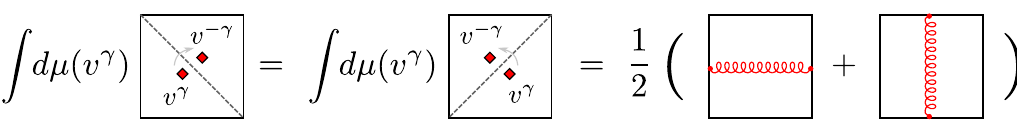
Figure 13 . At one-loop, gluing over a width-zero edge (one of the two diagonals of the square in the (cid:12)gure) is equal to the semi-sum of the two possible planar Yang-Mills exchanges in which the virtual particle crosses that